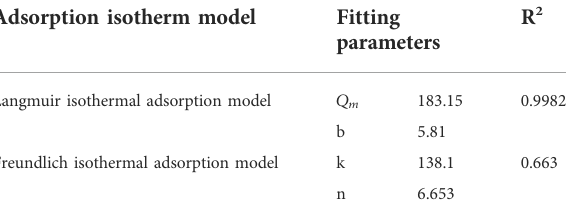
TABLE 2 Fitting results of adsorption isotherm model.